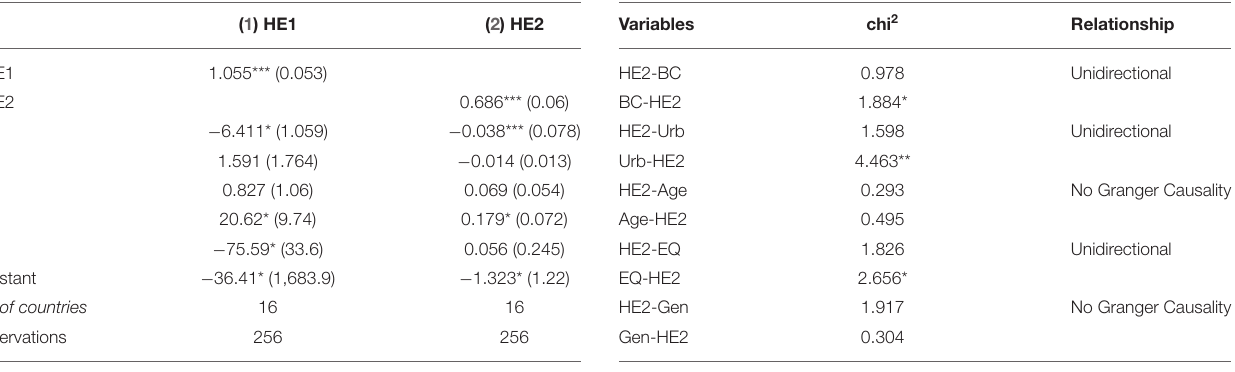
TABLE 5 | Robust GMM first differences panel modeling.